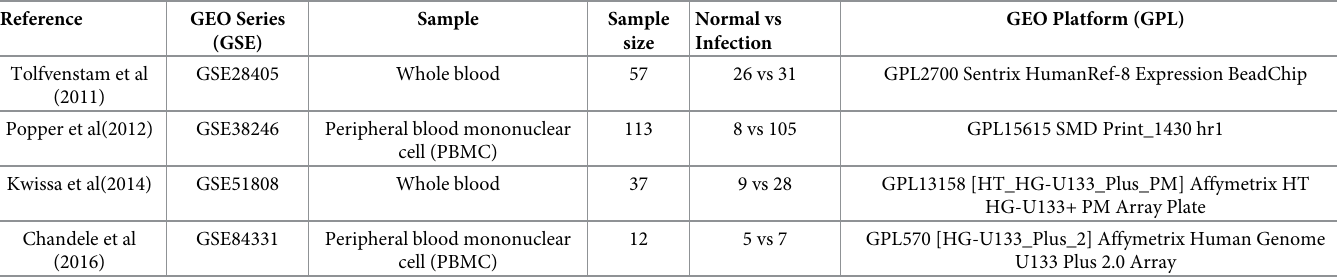
Table 1. Details of the data sources from Gene Expression Omnibus(GEO) for this